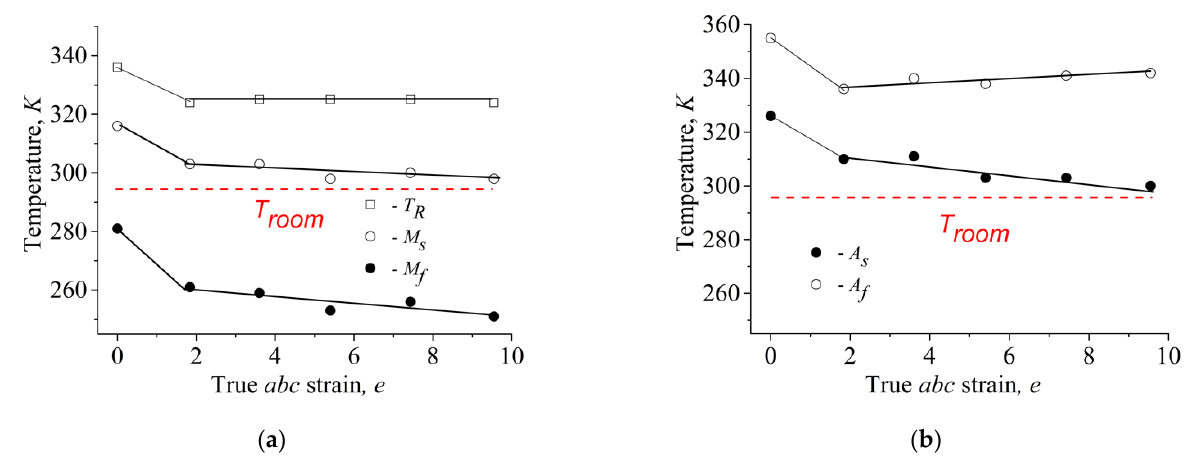
Figure 1. Martensite transformation temperatures versus true abc strain in Ti 49.8 Ni 50.2 : ( a ) on cooling; ( b ) on heating.